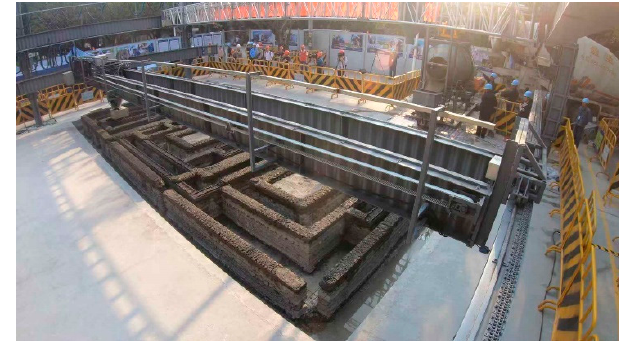
Figure 11. 3D printing of cable trench, foundation, and oil collection tank below the ground.